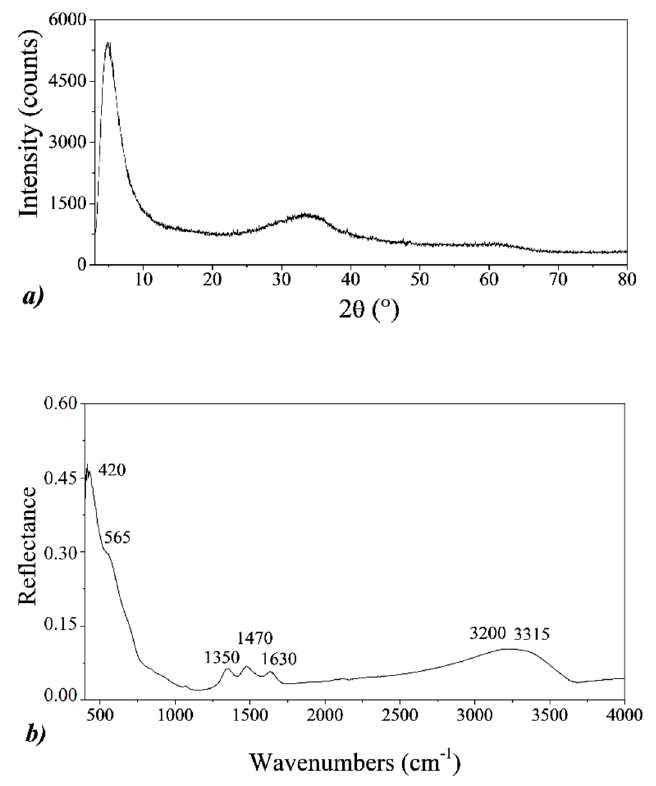
Figure 1. ( a ) XRD pattern and ( b ) attenuated total reflectance Fourier transform infrared spectroscopy (ATR-FTIR) spectrum of Fh 1M sample.